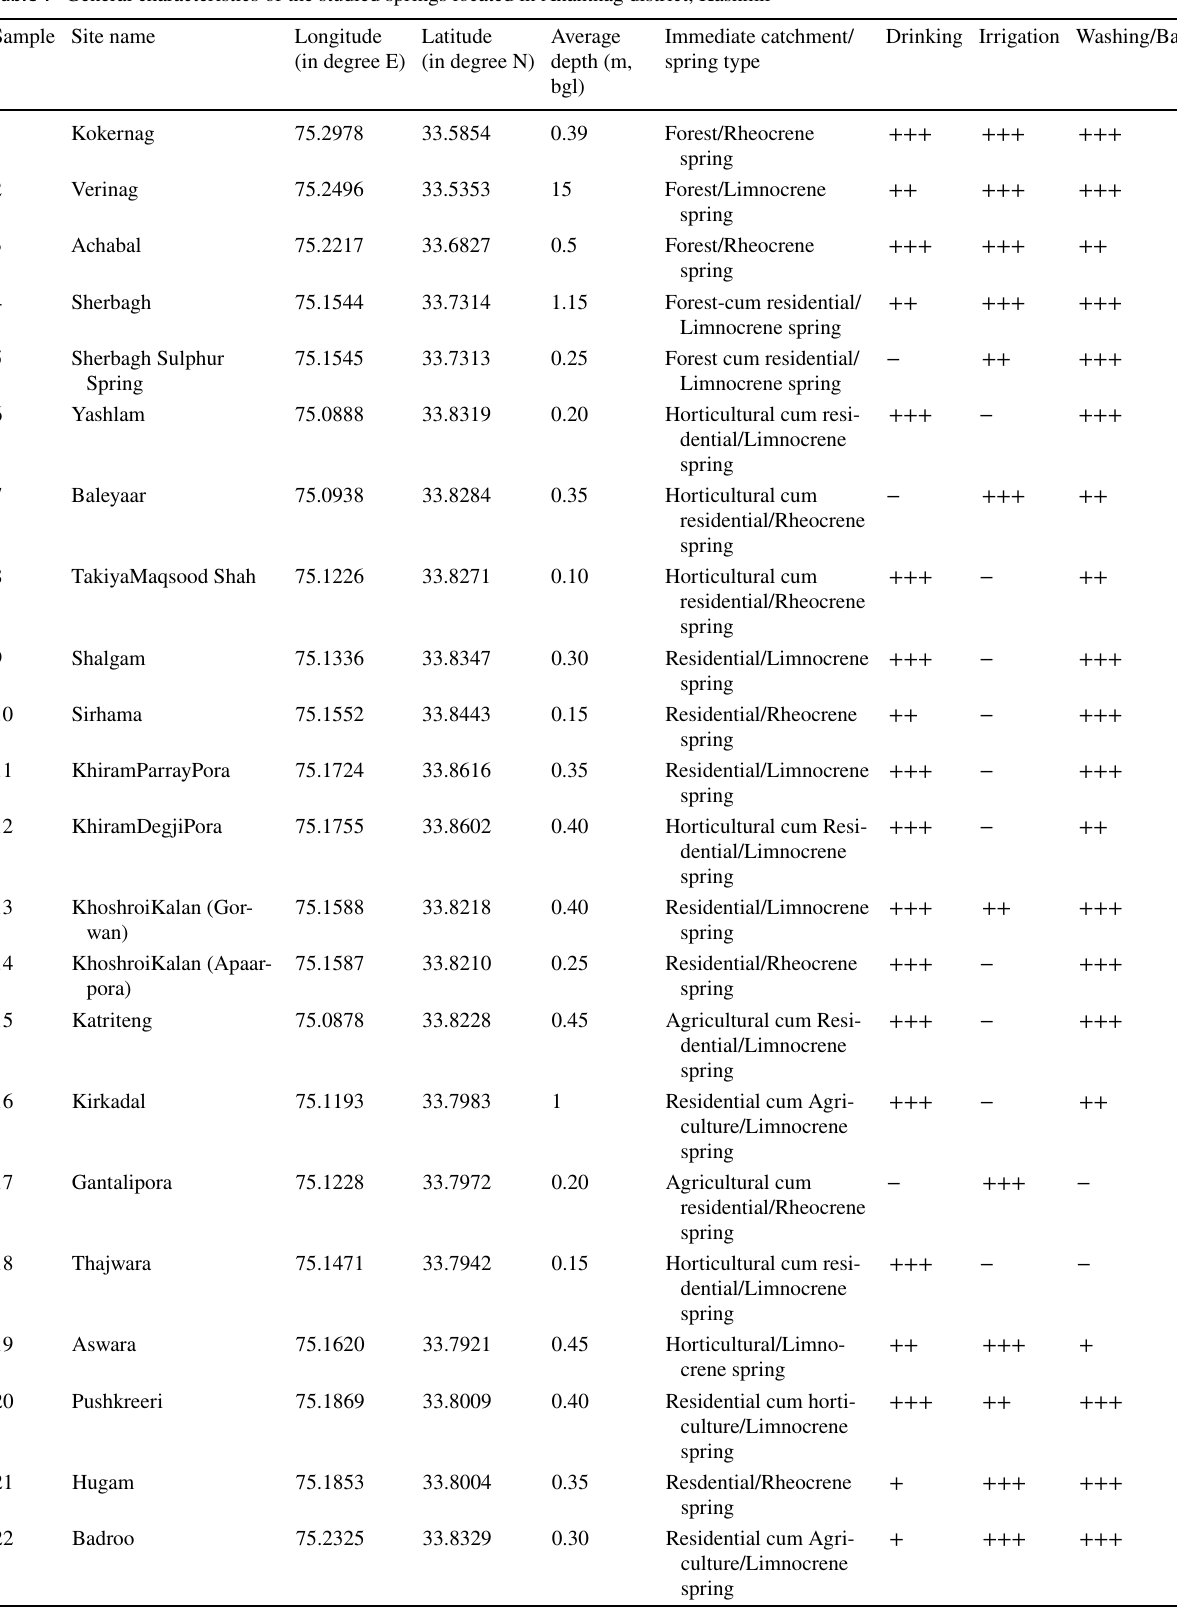
Table 1 General characteristics of the studied springs located in Anantnag district, Kashmir Sample Site